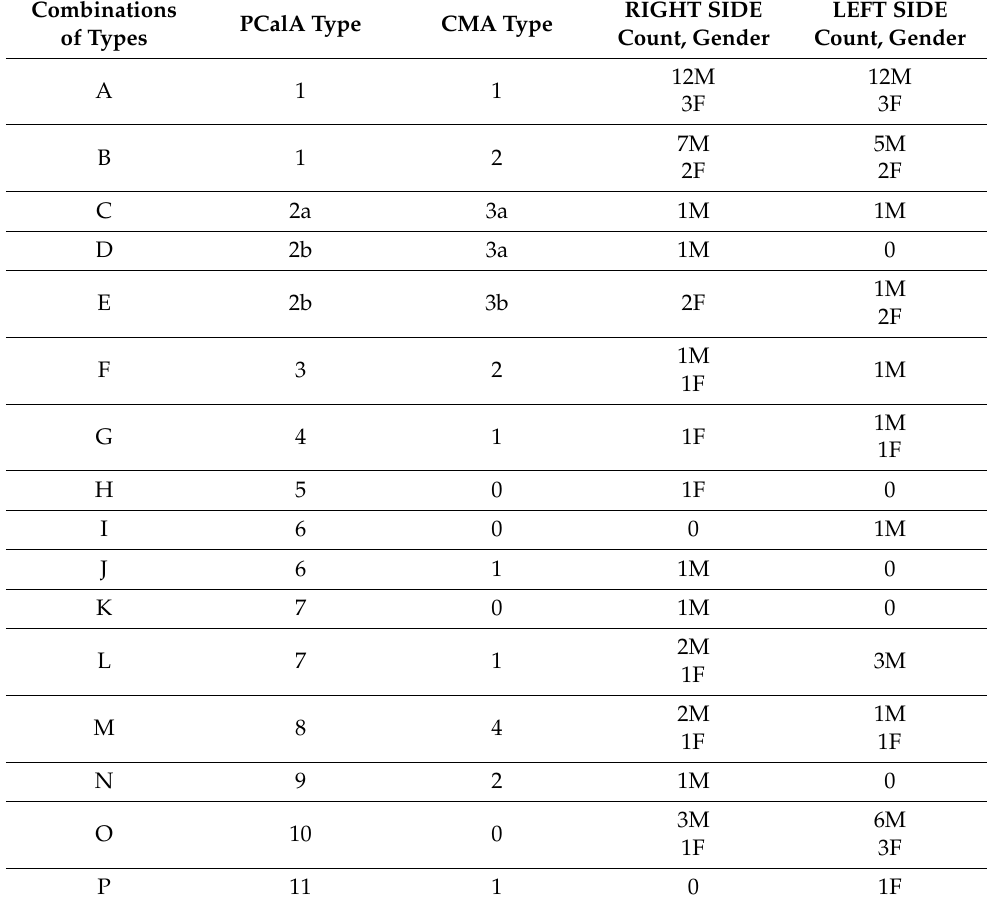
Table 2. Gender distribution of ipsilateral combinations of pericallosal (PCalA) and callosomarginal (CMA) arteries types. Types of combinations are defined and range from A to P. M: male; F: